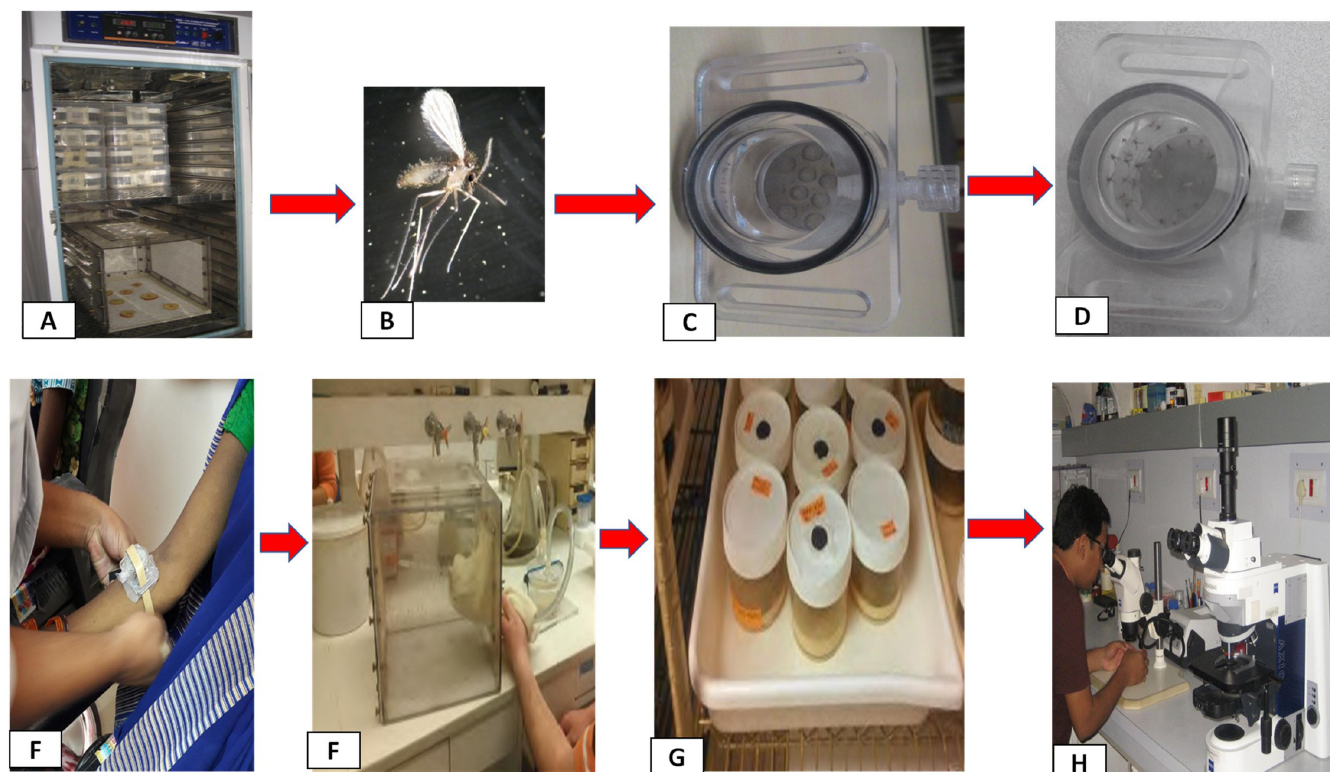
Fig 2. The infectivity of the subject can be tested with direct xenodiagnosis using sand fly vector female P . argentipes . (A) Pathogen free colony of sand fly. (B) Three- to-five day old unfed P . argentipes females removed from a colony cage. (C) An empty 2-inch diameter polycarbonate feeding chamber. ( D) Loaded with sand flies by mouth aspirator through a small entry port. The feeding chamber has a screen-mesh bottom, through which the sand flies can feed, and vented top to prevent moisture condensation that might entrap sand flies inside the chamber. ( E) The loaded feeding chamber (with 20 to 30 female P . argentipes ) is then strapped with the screened side against the skin by a band for 30 minutes on the arm or leg (location can be decided during xenodiagnosis process based on logistic as well as patients comfort). This procedure usually takes place in the xenodiagnosis room, separate from the closed colony insectary room. (F) After 30 minutes of feeding, the feeding chamber is removed from the patient’s arm or leg and sand flies are released from the feeding chamber into a polycarbonate holding cage where they can be separated as fed and unfed. (G) Only blood-engorged females sand flies are transferred into a 1-pint holding container with screen-mesh top and held for at least 72 hours in an environmental cabinet at 28˚C and 80% humidity with a 17:7 (Light: Dark) photoperiod. (H) All 3 to 5 days postfeeding surviving flies are then dissected and examined under the microscope for the presence or absence of Leishmania promastigotes. A subject will be considered positive for infectivity to sand flies if an infection is observed in at least one sand